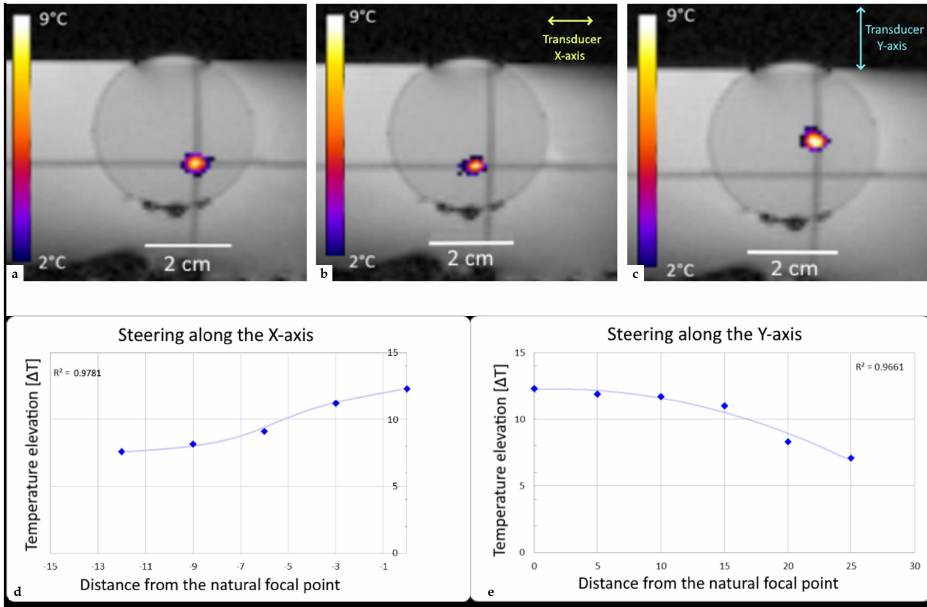
Figure 5. Study of steering capacities in the X and Y axes. ( a ) Sonication at the symmetry axis ( b ) sonication with steering of 8mm in the X-axis, and ( c ) sonication with steering of 15 mm in the Y-axis. ( d , e ) Tables of steering